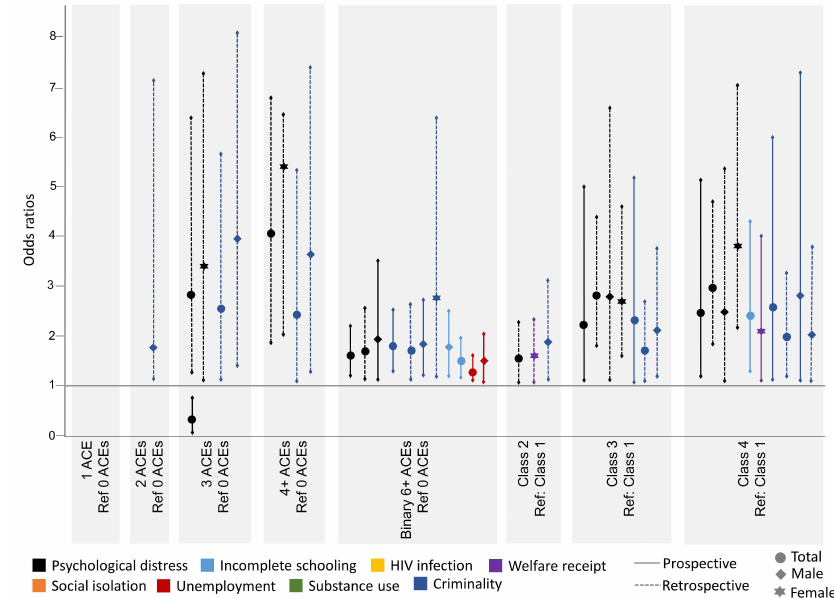
Figure 3. Significant adjusted associations (odds ratios) between cumulative and clustered ACEs and human capital outcomes, for the total sample and disaggregated by